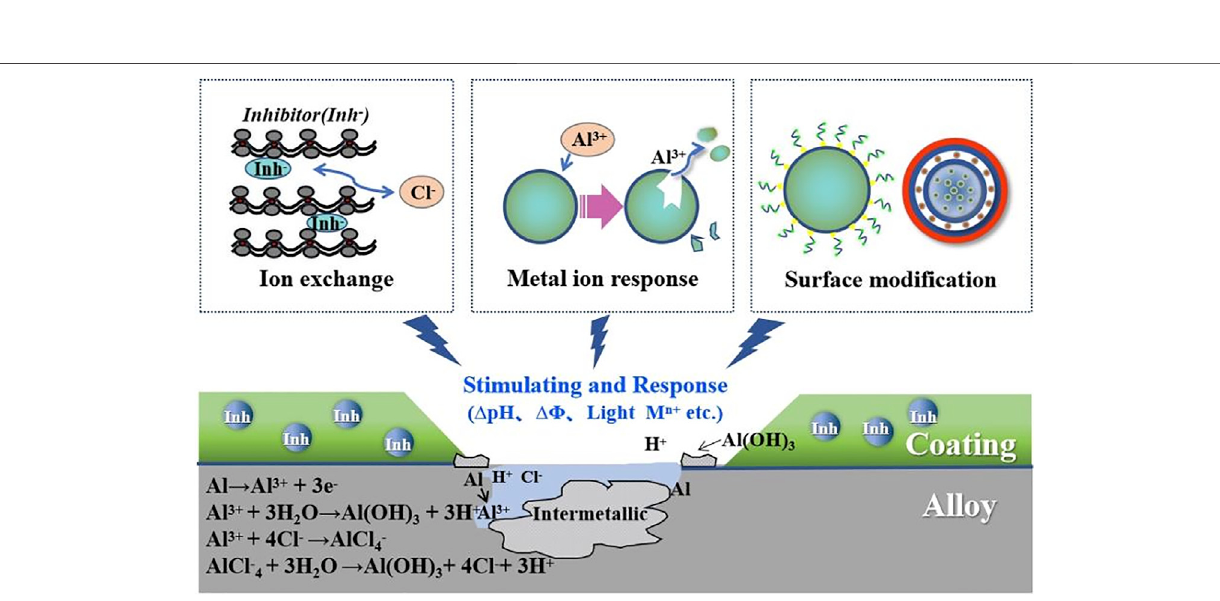
Frontiers in Materials |